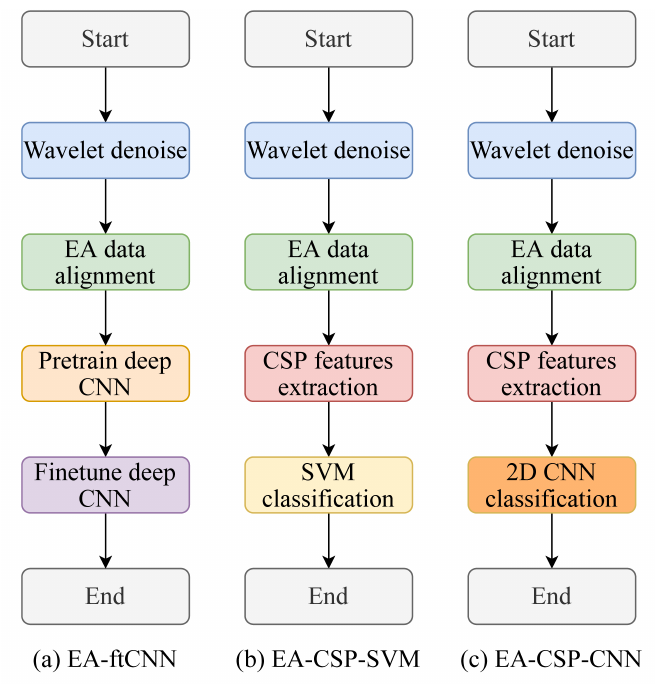
Figure 1. The experiment